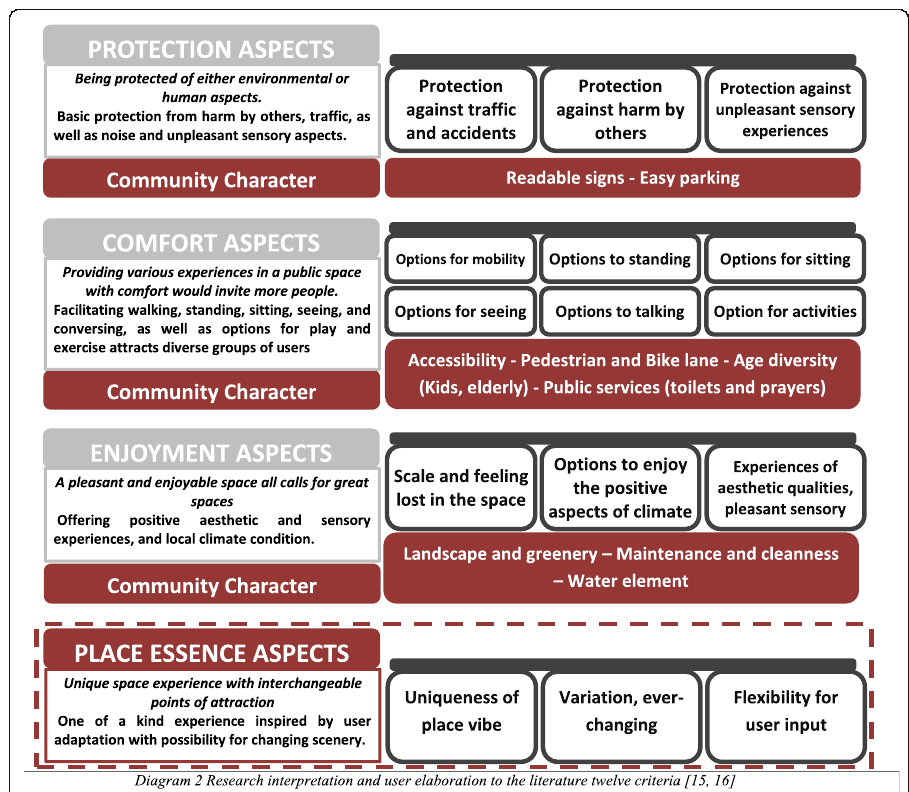
Fig. 27 Research interpretation and user elaboration to the literature twelve criteria [15,